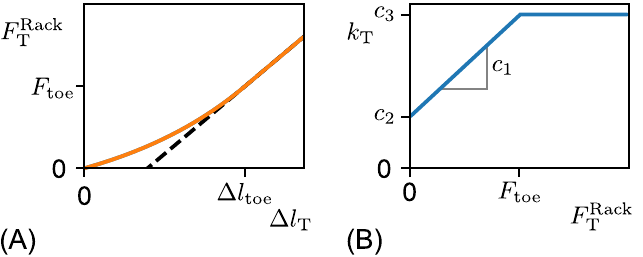
Fig 2. (A) Exponential elastic tendon lengthening model and its (B) stiffness as function of tendon force. In (A) the tendon force is shown over the change in tendon length in orange. As described in Eq (10). The linear force length relationship is extended with a dashed line. In (B) the stiffness k T of the exponential tendon model is shown over the tendon force F Rack . The tendon model parameters are marked in the plot. The non linear stiffness is configured by ( c 1 T and c 2 ). As shown in Eq (6) c 1 is the change in stiffness k T over a unit change in F . the parameter c 2 is the stiffness at ¼ 0 . At the force F toe , the model continuously transitions into a linear stiffness function. F Rack T